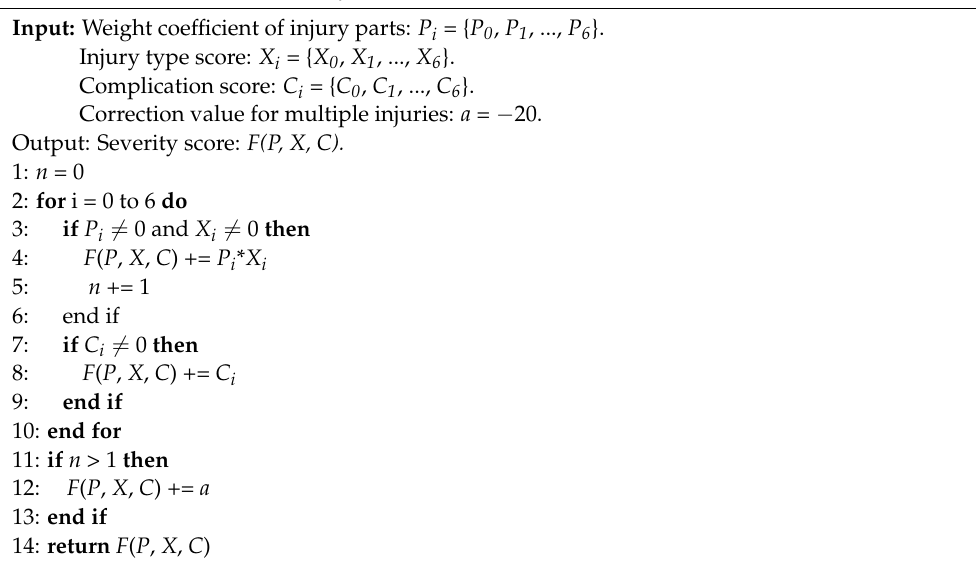
Algorithm 1. War trauma severity score (WTSS).